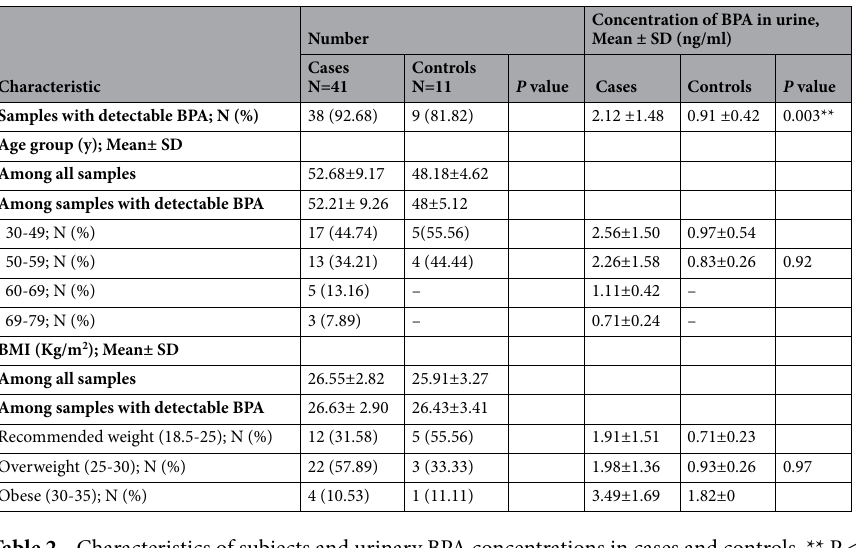
Table 2. Characteristics of subjects and urinary BPA concentrations in cases and controls. ** P < 0.01; comparison urinary BPA concentrations between cases and controls.